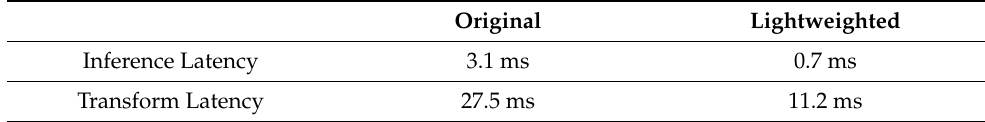
Table 8. Lightweighted models’ overhead versus original